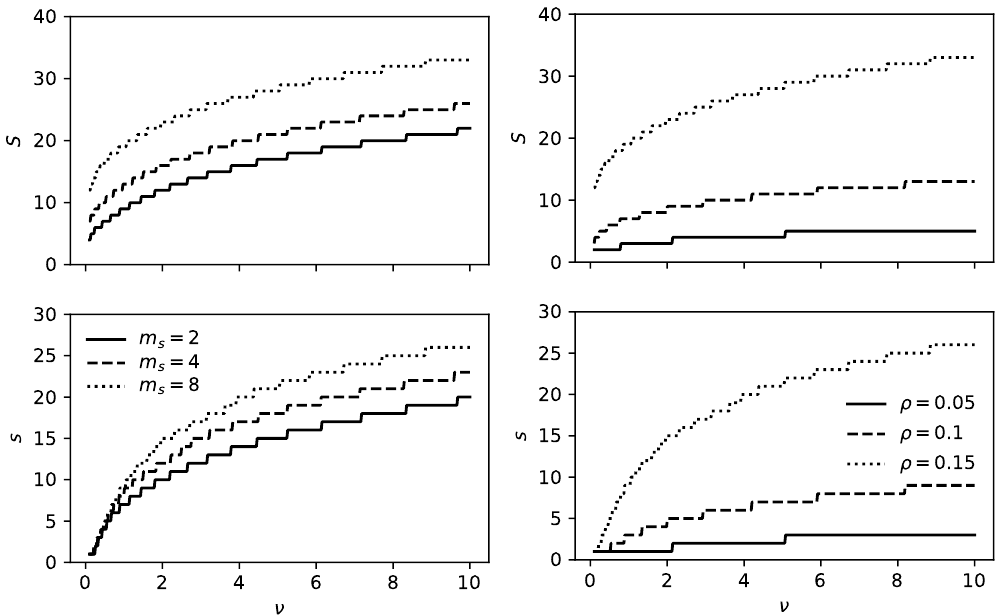
Figure 5. Optimal ( s , S ) -policy vs. the cost weight parameter ν for different mean setup times m s ( left ) and for different load ρ ( right ) as